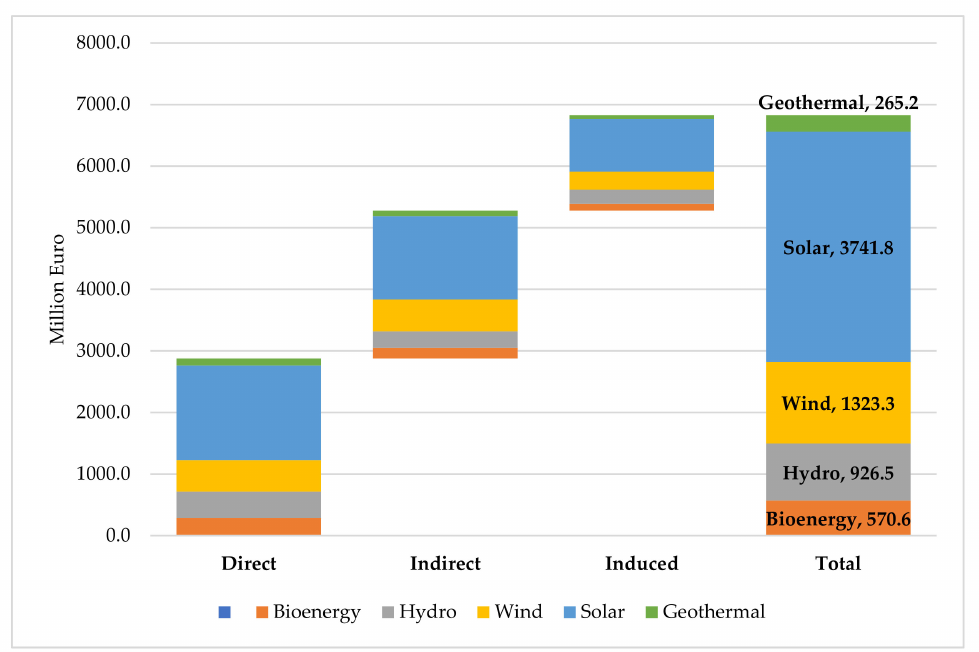
Figure 2. Breakdown of total contribution to GDP from RES deployment per